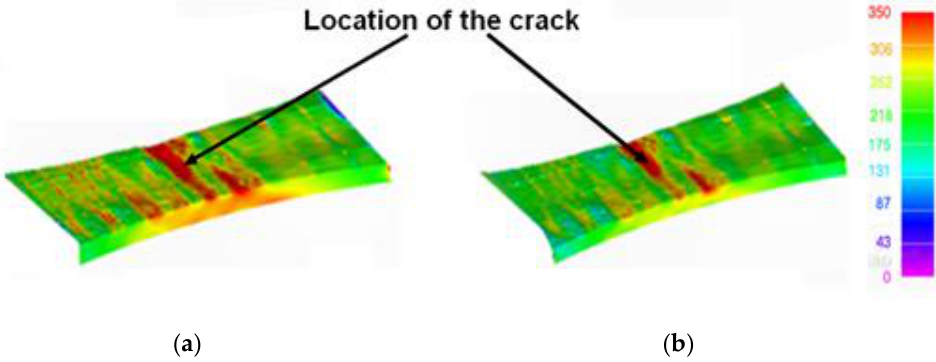
Figure 8. The stress fields in the ( a ) as-built, and ( b ) partially machined specimens.